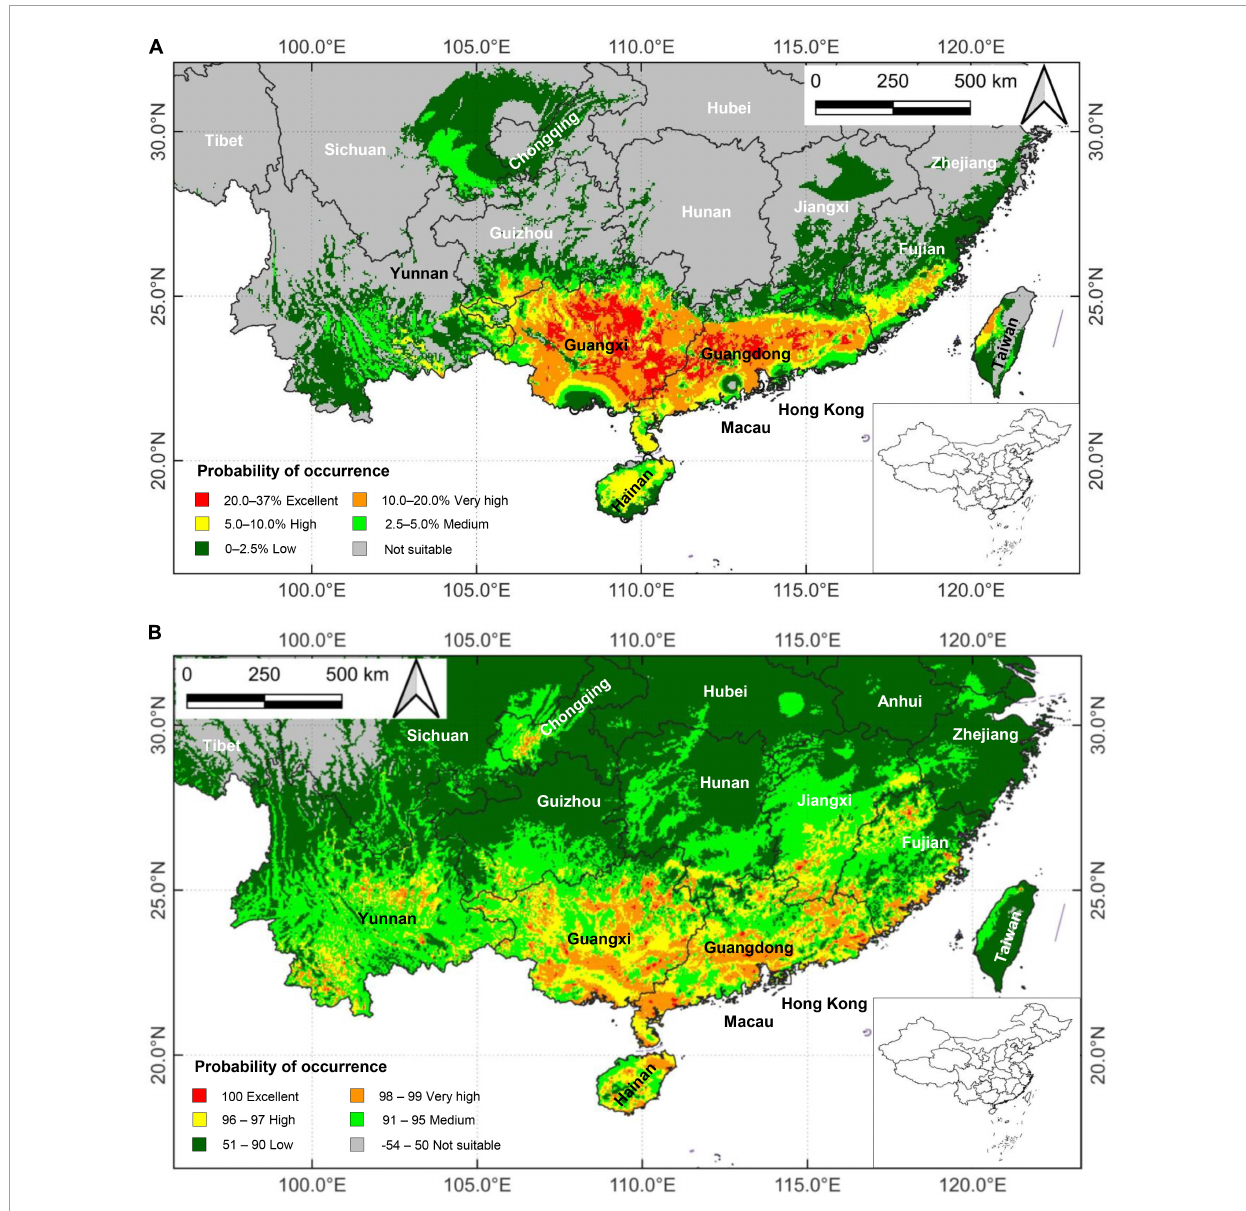
FIGURE5 Potential suitable habitats of Mimosa bimucronata under the climate change scenario (double CO 2 concentration) in 2100 generated by the: (A) BIOCLIM model; and (B) DOMAIN model. Red color denotes excellent suitability habitat, orange very high, yellow high, light green medium, dark green low, and gray not